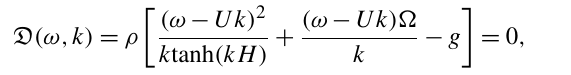
Figure 2. (a) A Bragg triad in the absence of mean velocity. Wavenumber k has been nondimensionalized by 1 /H ( H ≡ flow depth), and √ √ g/H , i.e., ω ∗ ≡ ω/ g/H . (b) Bragg triads in the presence of “Couette-type” mean velocity with U ∗ ≡ U/( frequency ω by In the shaded region, three Bragg triads can exist for a given k . For labels, see the